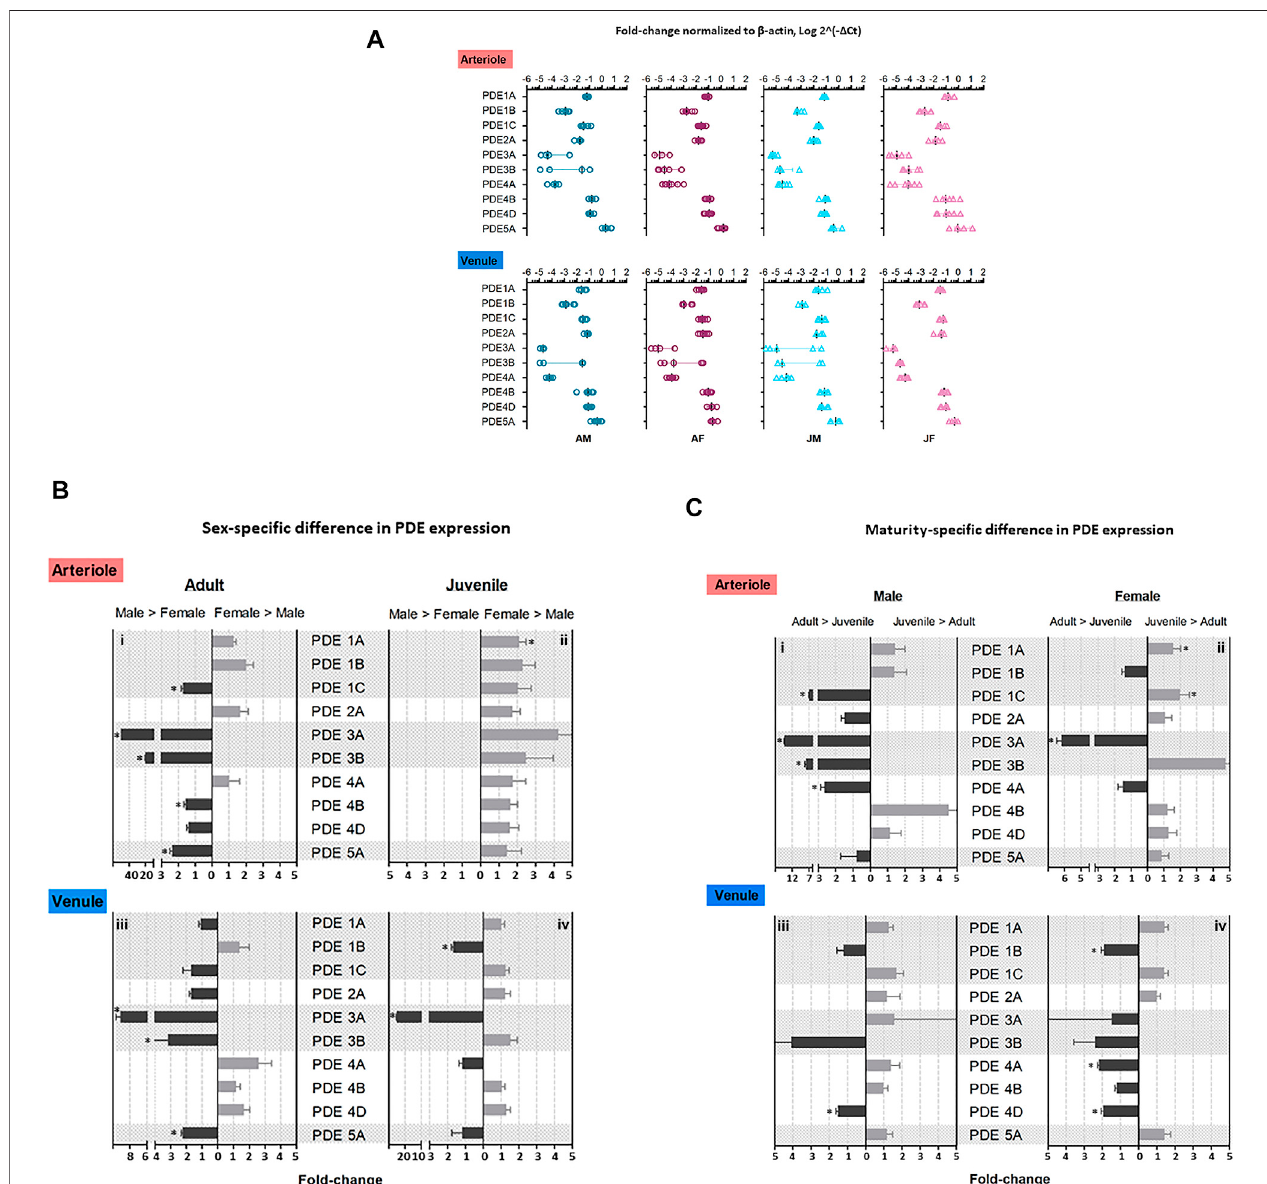
FIGURE 1 | Expression level of PDE1-5 transcripts in adult and juvenile skeletal muscle arterioles and venules of male and female rats. Arterioles and venules were isolated from abdominal skeletal muscles of four group rats: adult males (AM), adult females (AF), juvenile males (JM), and juvenile females (JF). Microvessel PDE 1-5 mRNA expression was measured by using TaqMan real-time RT-PCR assay. (A) The fold-change relative to β -actin for PDE gene expression was calculated as 2 − Δ Ct , where Δ Ct (cid:2) Ct targetgene – Ct β -actin .PDE5AmRNAlevels werethe highestamongten genesinarterioles and venules in each group ( n (cid:2) 4 – 7, # p < 0.05).The orderof expression levels in PDE1 family: 1A ≈ 1C > 1B; likely for PDE4 family, 4B ≈ 4D > 4A. Expression levels of PDE3 family were relatively low vs. other families, in which there was no signi fi cant difference between PDE3A and PDE3B although there was a trend of low expression for PDE3A. These expression patterns were similar for both arterioles and venules in four group rats. (B) Sex-speci fi c difference in PDE 1-5 mRNA levels. The relative fold-change between males and females were calculated by 2 − ΔΔ Ct , where ΔΔ Ct (cid:2) Δ Ct (high expression) – Δ Ct (low expression) . In arterioles, levels of PDE1C, 3A, 3B, 4B, 5A were greater in adult males compared with adult females (i) ; PDE1A level was greater in juvenile females compared with juvenile males (ii) . In venules, expression levels of PDE3A, 3B, and 5A were higher in adult males compared withadult females (iii) ; PDE1Band 3Awerehigher injuvenile males comparedwith juvenile females (iv) . (C) Reproductivematurity-speci fi cdifference inPDE 1-5mRNA level. Using the similar analysis to sex-speci fi c difference, the fold-change between adult and juvenile with the same sex was expressed as 2 − ΔΔ Ct . In arterioles, expression levels of PDE1C, 3A, 3B, 4A were greater for adult males compared with juvenile males (i) ; PDE1A and 1C expression for juvenile females exceeded the counterparts foradult femalesand only PDE3Alevel wasgreater foradult females relativetojuvenile females (ii) .In venules, PDE4D wasgreater inadult malesrelative to juvenile males (iii) whereas adult females expressed higher levels of PDE1B, 4A, and 4D relative to juvenile females (iv) . The data are means ± SEM of fold-changes. Experimental replication was 4 – 7 ( n (cid:2) 4 – 7) and * indicates p < 0.05.